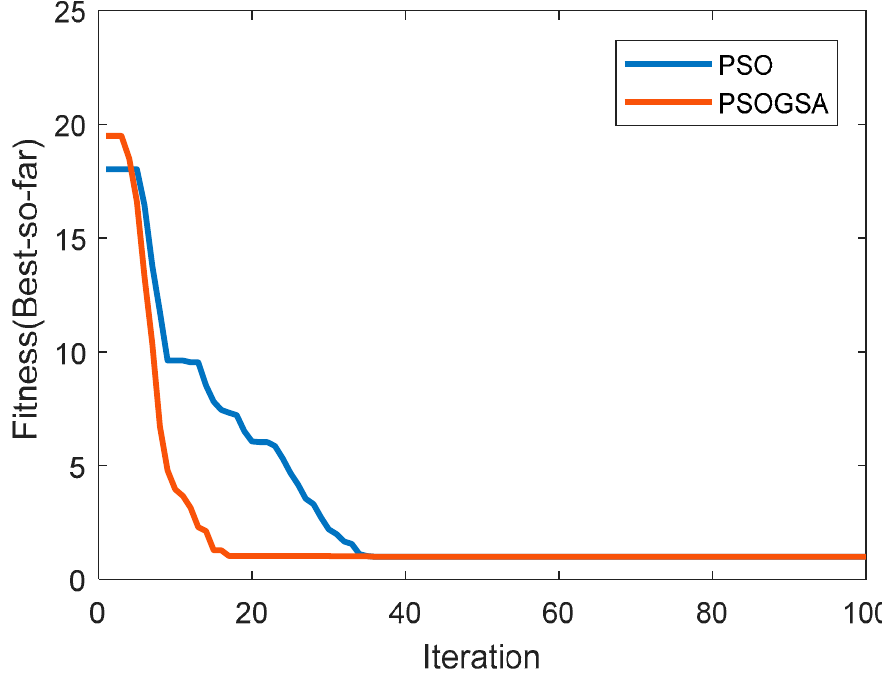
11 of 22 Table 3. Initial parameters for PSO-GSA. Parameter